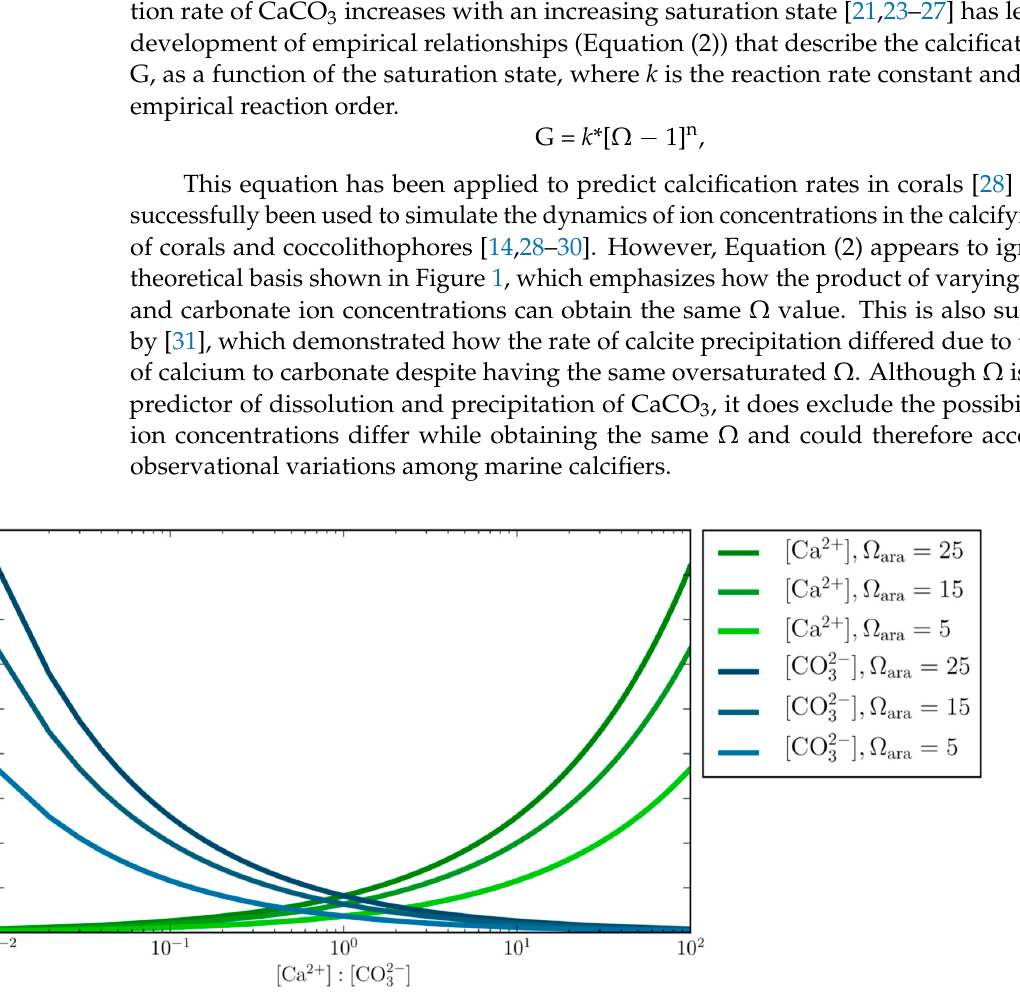
Figure 1. Varying concentrations of calcium and carbonate ions [Ca 2+ :CO 32- ] at fixed Ω ara of 25, 15, and 5. This demonstrates the underlining principle that calcium and carbonate ion concentrations can obtain the same Ω ara value at different Ca:CO 3 ratios, therefore questioning the empirical equation that prescribes the calcification rate as a function of Ω ara alone.